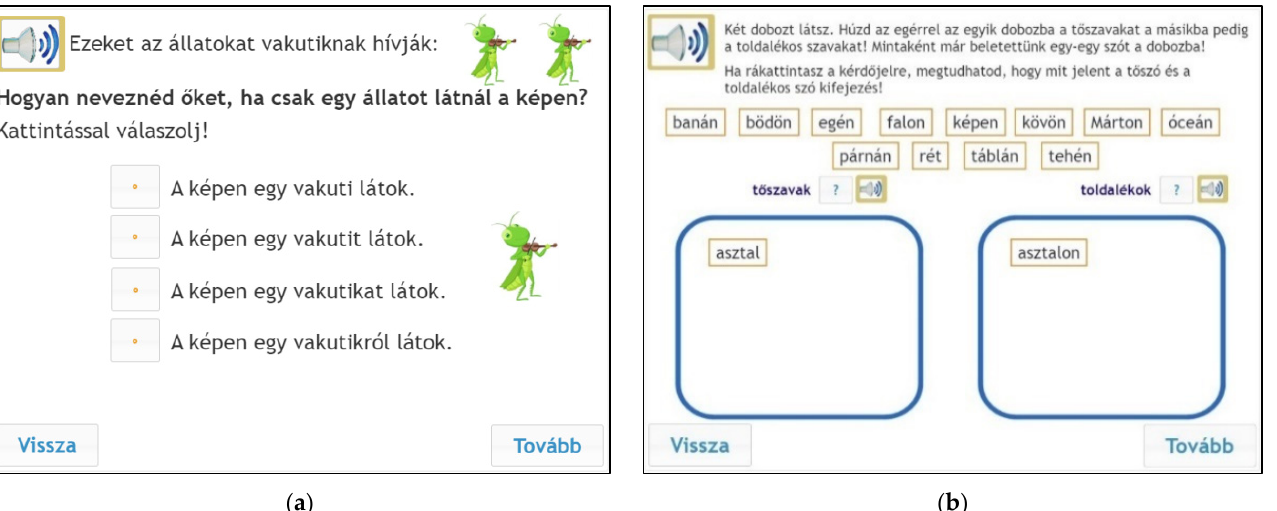
Figure 1. Sample items for affix identification. Left ( a ): nonwords, instruction: “These animals are vakutis. What do you say if there is only one animal in the picture? Answer by clicking”. Options: I can see vakuti in the picture/I can see a vakuti in the picture/I can see a vakutis in the picture/I can see about vakutis in the picture. Right ( b ): real words, instruction: “You can see two boxes on the screen. Drag the base words into one box and the inflected words into the other box. We have already put one word into each box as an example. If you click on the question mark, you can learn what base word means and what affixed word means”. Options: banana, pot, in the sky, on the wall, in the picture, on the stone, Martin, ocean, on the pillow, meadow, on the board,